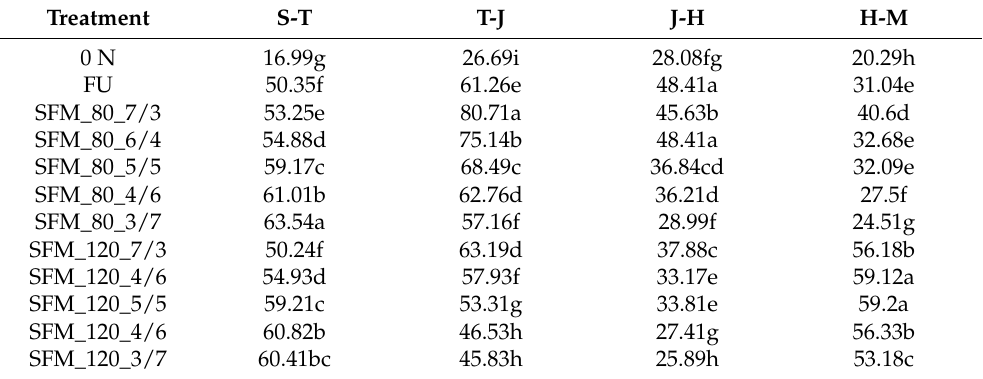
Table 6. Effects of different fertilization modes on the nitrogen accumulation (kg ha − 1 ) of rice.